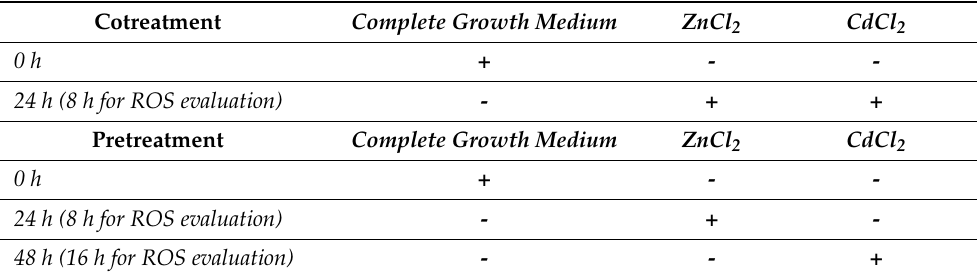
Table 1. RBE4 cell line treatments. (+) present; (-) not present. Cotreatment Complete Growth Medium ZnCl 2 CdCl 2 0 h + - - 24 h (8 h for ROS evaluation) - + + Pretreatment Complete Growth Medium ZnCl 2 CdCl 2 -